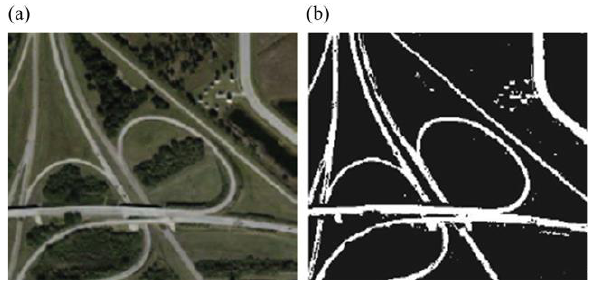
Figure 7. Road and road network extraction results. (a) Input image. (b) Output